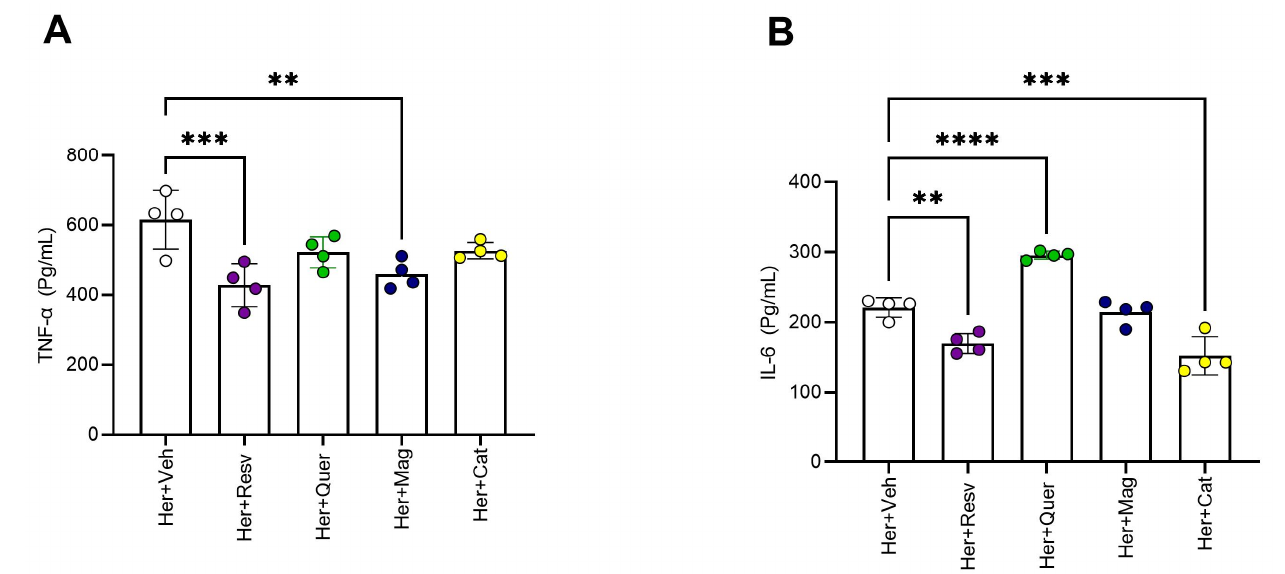
Figure 5. The effect of polyphenols on striatal TNF α and IL-6 and concentration. ( A ) Resveratrol and magnolol attenuate heroin-induced increase in striatal TNF- α concentration: Significant differences in striatal TNF- α concentrations were evident by one-way ANOVA [F(4, 15) = 6.885, p < 0.01]. Dunnett’s multiple comparisons test against Her + Veh control group (n = 4) showed significant effect of resveratrol [mean difference in striatal TNF- α concentration between heroin and heroin+ resveratrol groups = 187.4, 95% CI = 81.40 to 293.4, p < 0.001], and magnolol [mean difference in striatal TNF- α concentration between heroin and heroin+ magnolol groups = 155.9, 95% CI = 49.84 to 261.9, p < 0.01] on TNF- α concentration. ( B ) Resveratrol and β -catechin attenuate, while quercetin accentuates, heroin-induced increase in striatal IL-6 concentration: Significant differences in striatal IL-6 concentrations were evident by one-way ANOVA [F(4, 15) = 42.74, p < 0.0001]. Dunnett’s multiple comparisons test against Her + Veh control group (n = 4) showed significant effect of resveratrol [mean difference in striatal IL-6 concentration between heroin and heroin+ resveratrol groups = 51.11, 95% CI = 18.24 to 83.98, p < 0.01], quercetin [mean difference in striatal IL-6 concentration between heroin and heroin + quercetin groups = − 74.66, 95% CI = − 107.5 to − 41.78, p < 0.0001], and β -catechin [mean difference in striatal IL-6 concentration between heroin and heroin+ β -catoctin groups = 68.69, 95% CI = 35.82 to 101.6, p < 0.001] on IL-6 concentration (** p < 0.01, *** p < 0.001, **** p < 0.0001).